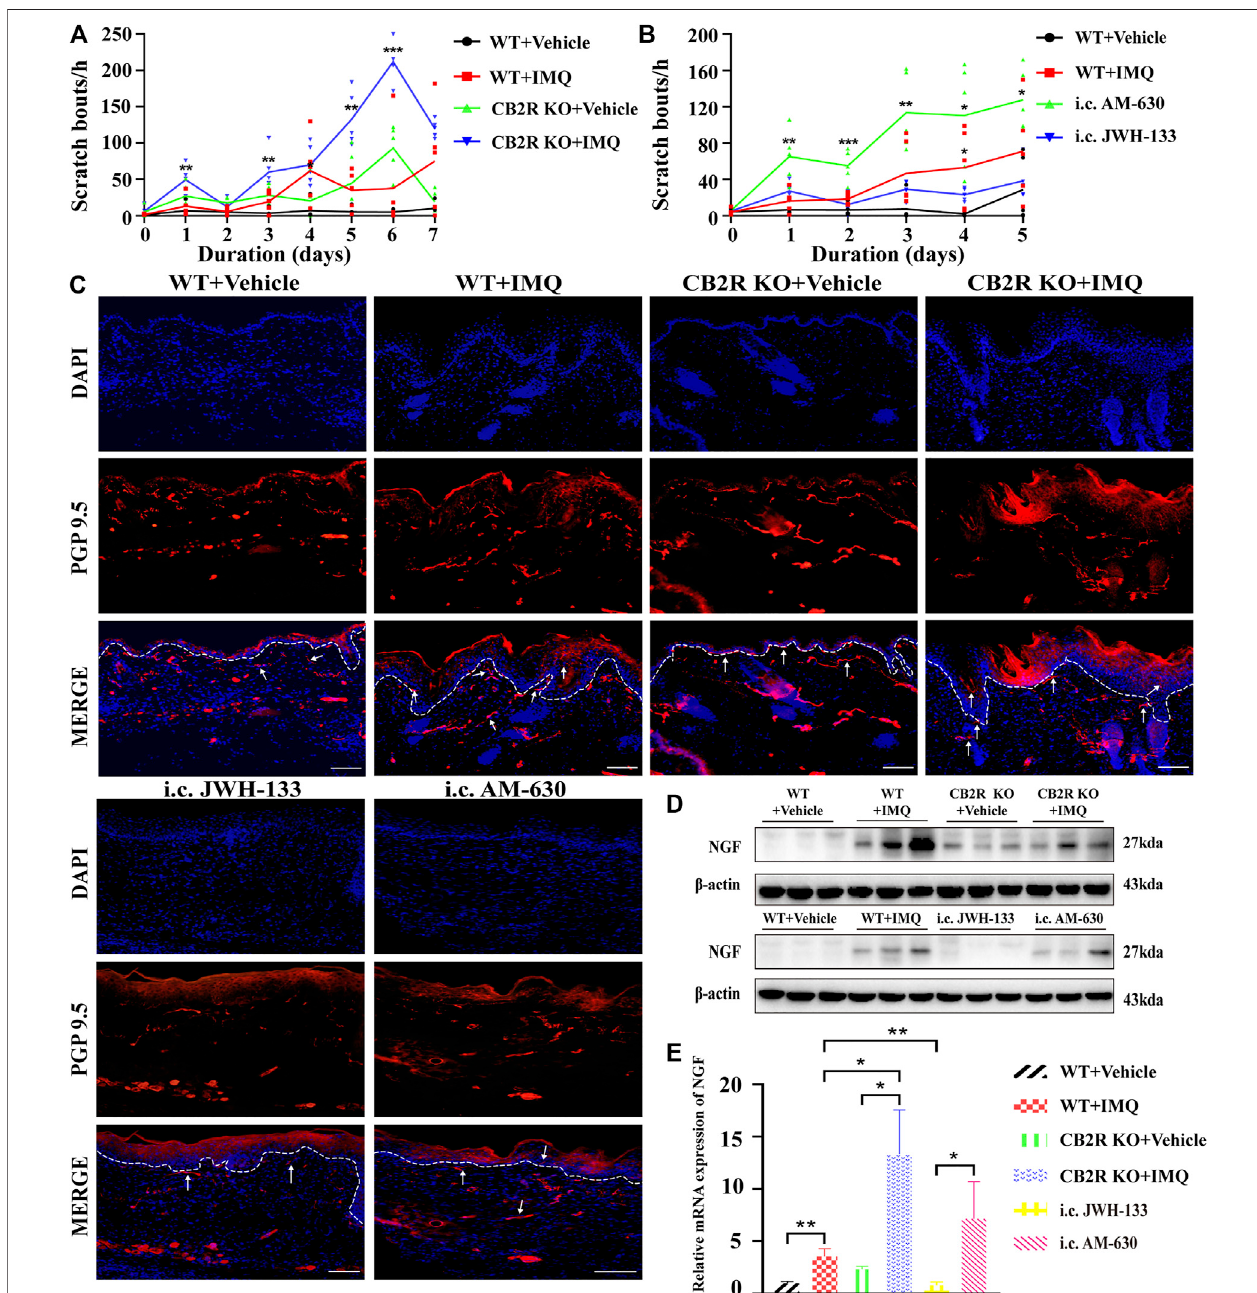
FIGURE5 | Effects of CB2R on the scratching behavior and expression ofnerve fi bers inIMQ-induced PsD. (A, B) The behavior results ofmice in different groups. (C) PGP 9.5 stained (red fl uorescence) nerve fi bers in the skin biopsies from mice, co-stained with DAPI (blue fl uorescence) to detect the nucleus. Scale bar represents 100 μ m. (D) Protein level of NGF was analyzed by western blotting in the six groups of mice. β -actin served as the loading control. (E) The mRNA expression levels of NGF was measured by qRT-PCR. Error bars represent mean ± SD. ( n = 5 for each group). * p < 0.05, ** p < 0.01, and *** p < 0.001 when compared. All the assays were repeated three times with consistent